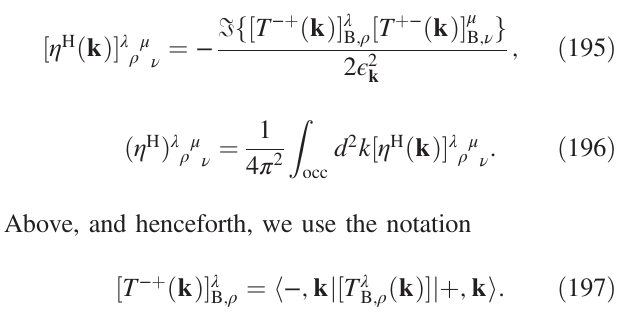
FIG. 1. A plot of the total Hall viscosity η H function of mass m ∈ ½ − 4 ; 4 (cid:2) for the C 4 symmetric Chern insulator. We fix the hopping parameters t ¼ r ¼ 1 and set the lattice constant a ¼ 1 . The viscosity is measured in units of ℏ =a 2 . We see that each viscosity is odd in the mass parameter m , and all go to zero as j m j → ∞